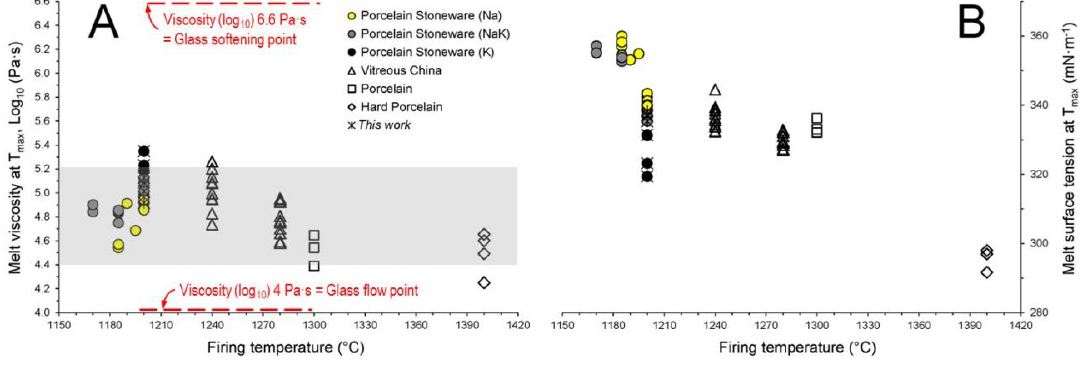
Figure 8. Correlation of viscosity ( A ) and surface tension ( B ) of the vitreous phase versus the firing temperature of the melt in porcelain stoneware compared with other porcelain-like materials.